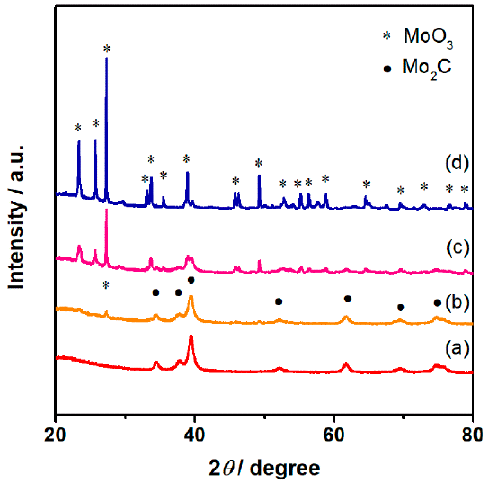
Figure 7. XRD patterns of (a) MC-270, (b) MC-305, (c) MC-450 and (d)